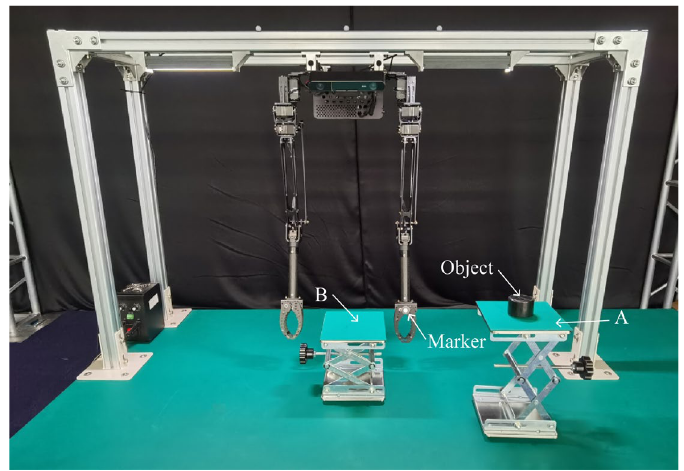
Figure 10. Motion trajectory accuracy and repeatability test of manipulator.